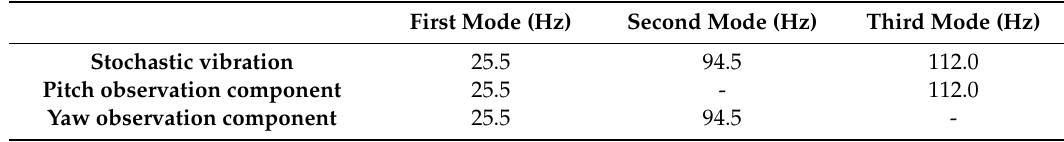
Table 2. Comparison results observed in the lab.